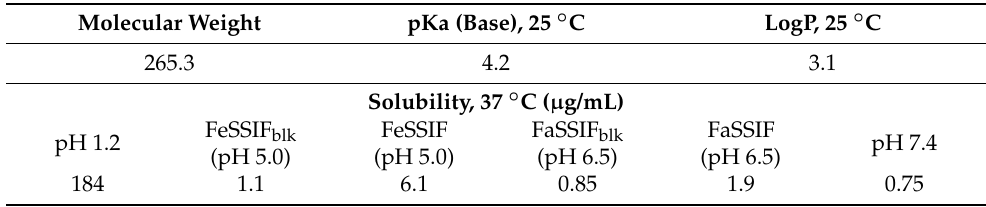
Table 1. Basic Properties of ALZ [16–18]. Molecular